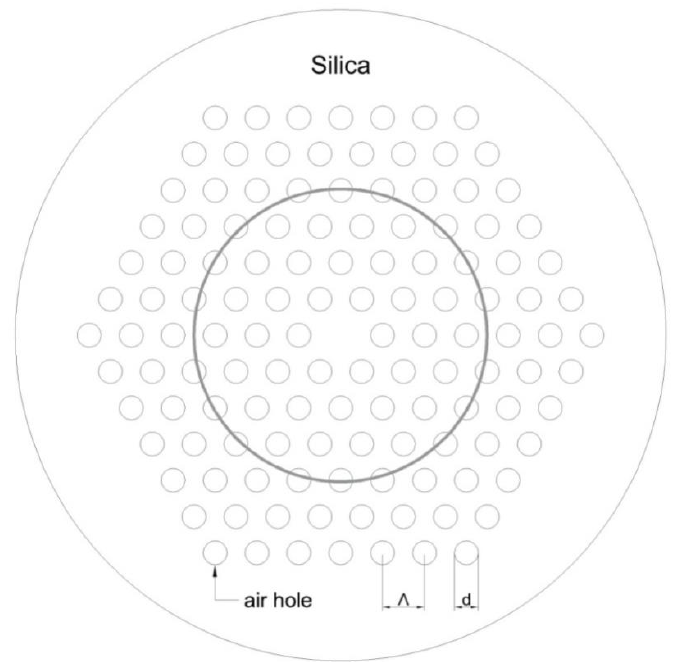
Figure 2. Schematic depiction of the alternating step index resulting from radial discretization in a standard photonic crystal fiber (PCF).